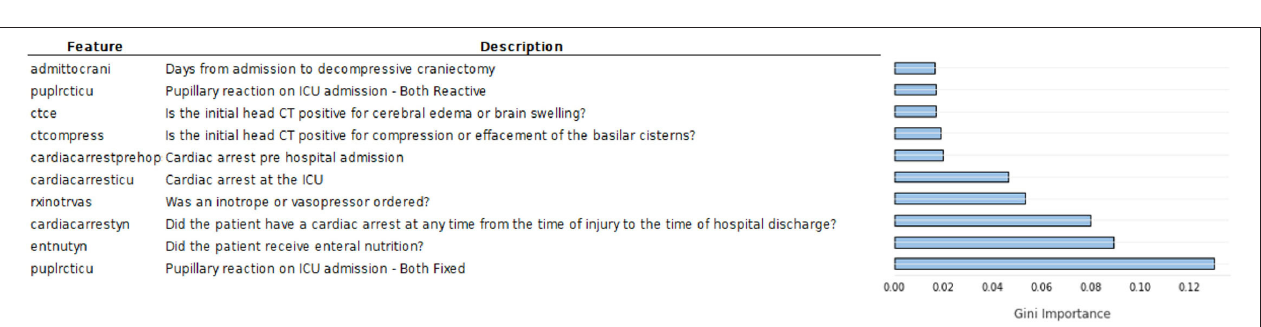
FIGURE 5 | Ten most important features according to Gini feature importance computed by random forest.